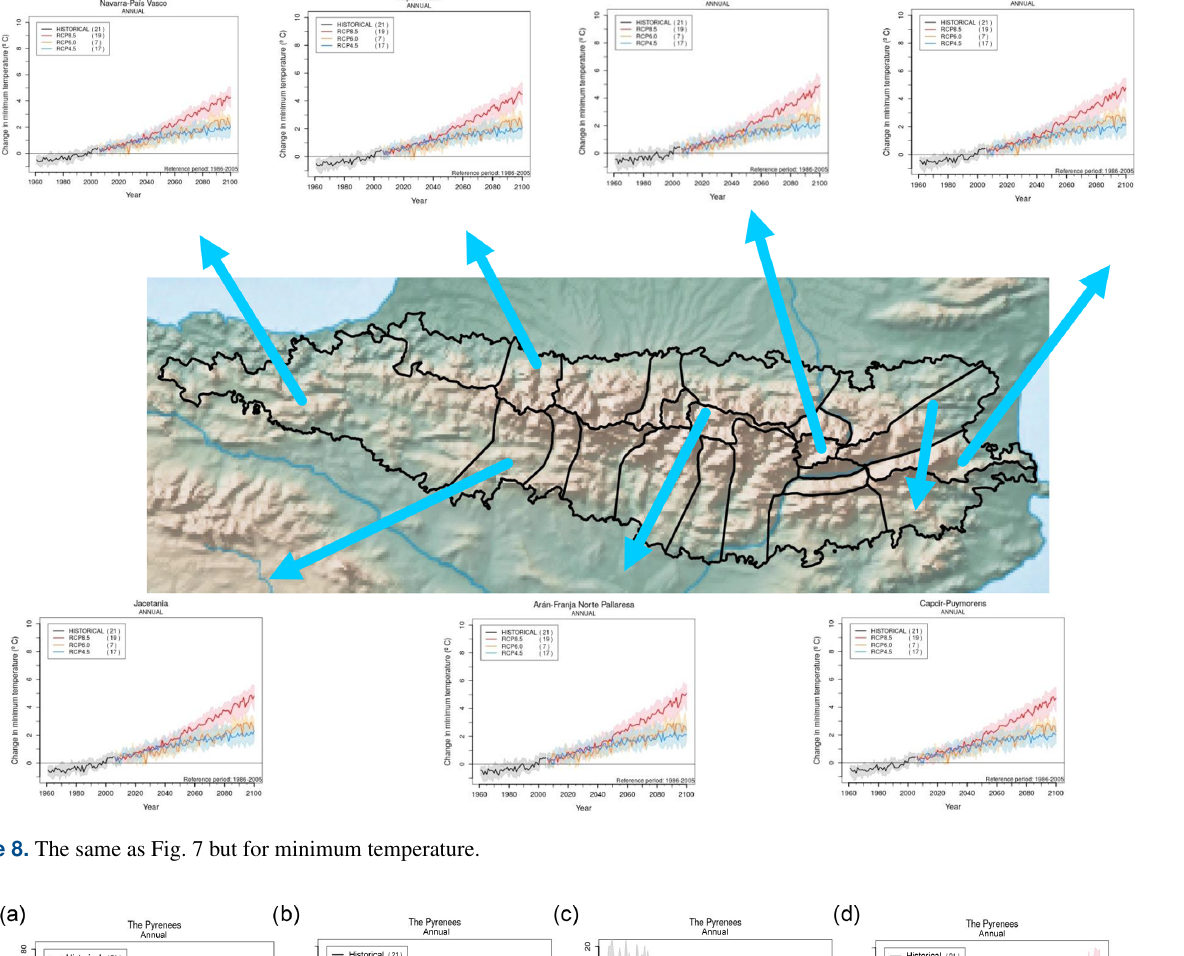
Figure 8. The same as Fig. 7 but for minimum temperature.